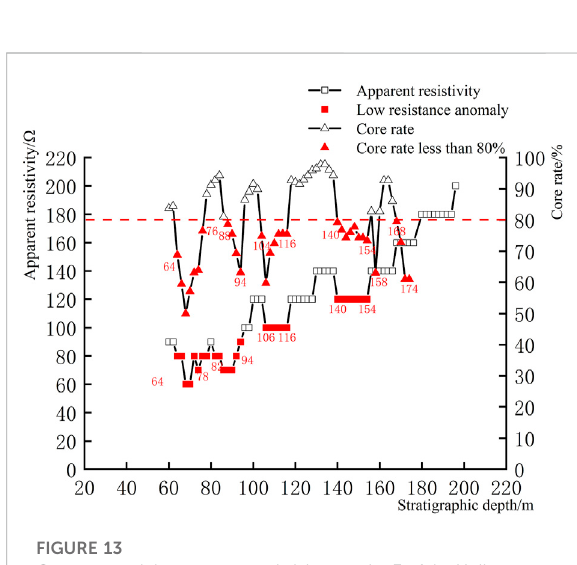
FIGURE 11 Location of the drilling.